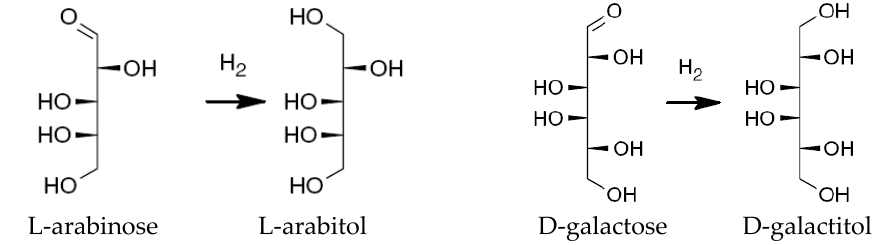
Figure 1. Reaction scheme of arabinose and galactose